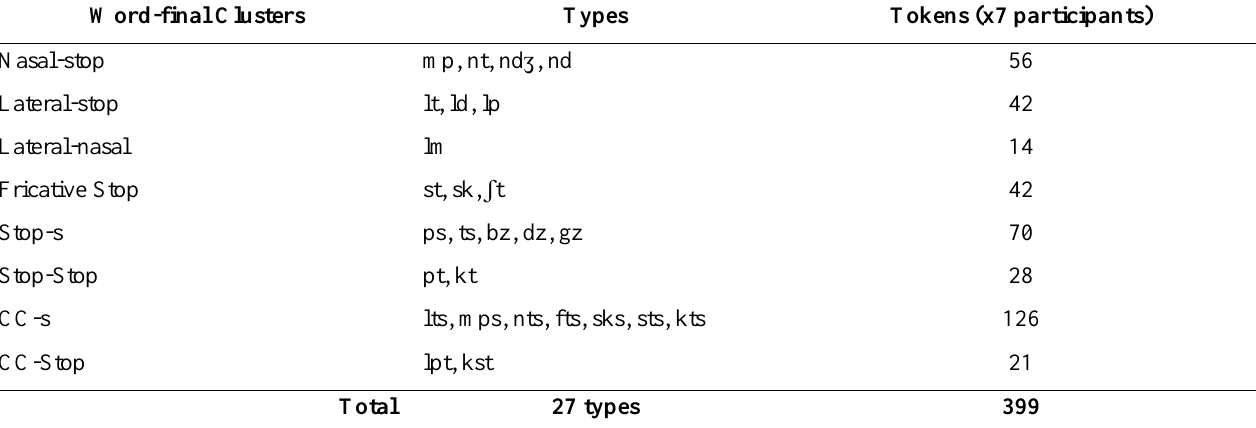
Table 2. Word-final